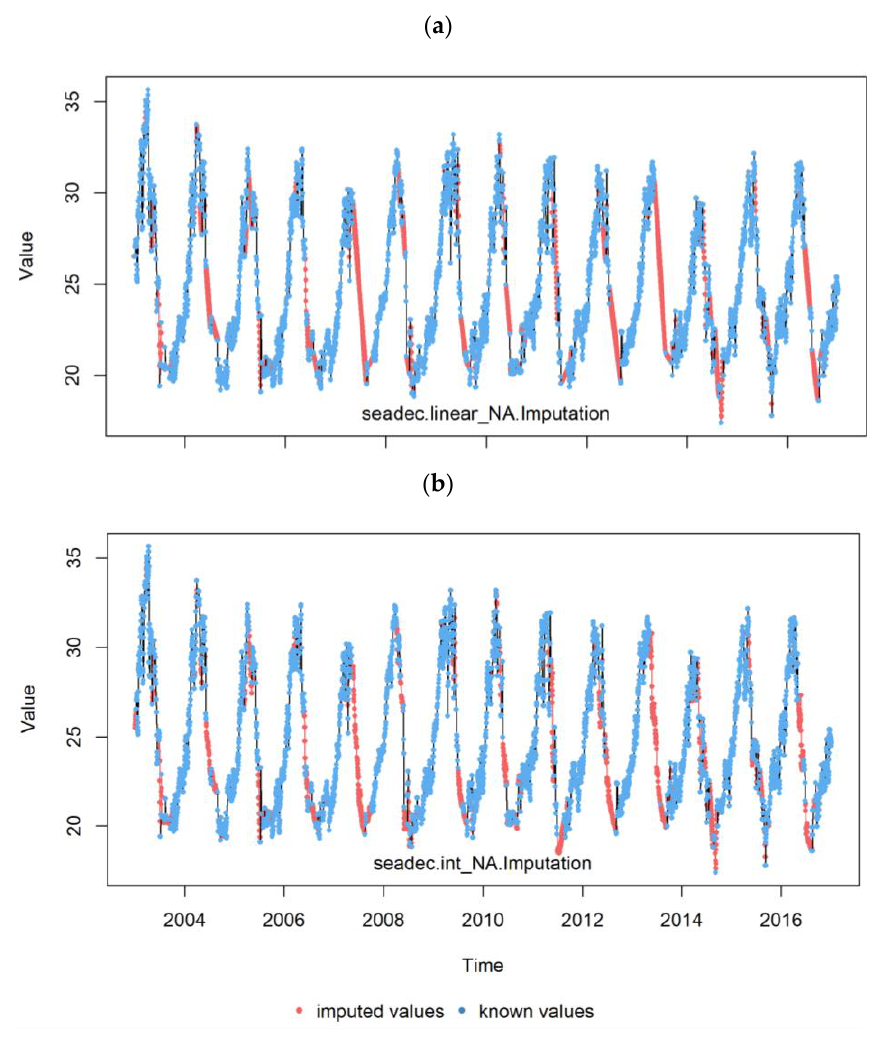
Figure 4. MODIS LST missing data imputation using ( a ) simple linear and ( b ) seasonal decomposition with interpolation algorism methods for Lay Birr meteorological station for 2003–2016.